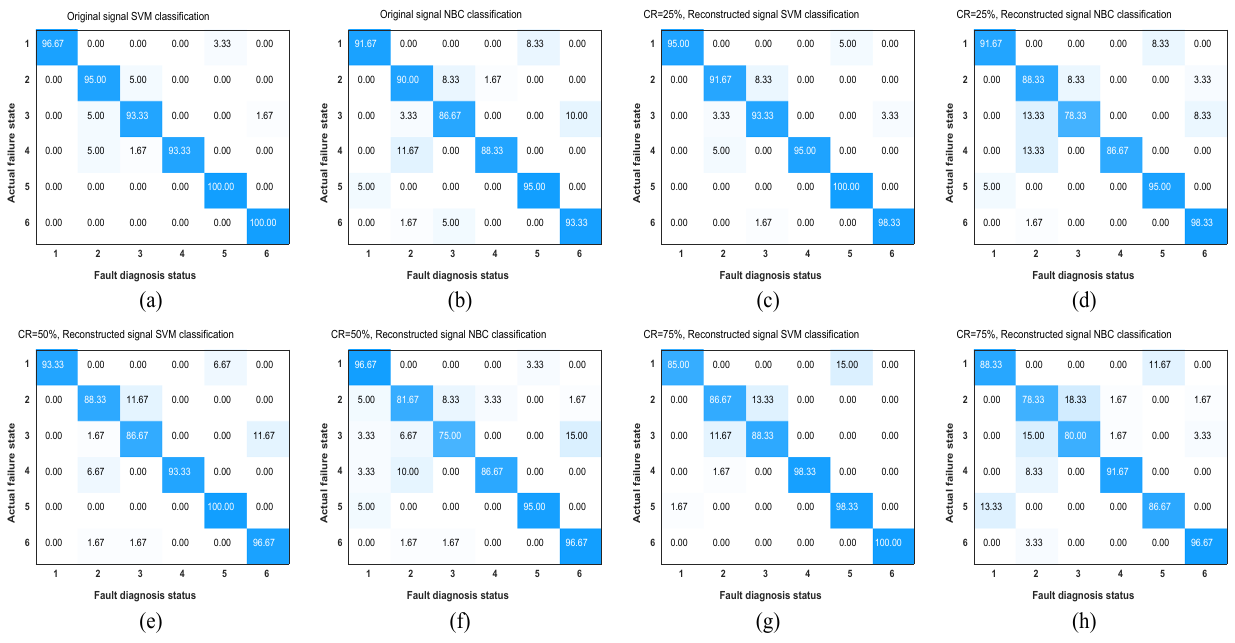
Figure 11. Comparative analysis of fault classification under different compression ratios: ( a ) Original signal SVM classification; ( b ) original signal NBC classification; ( c ) CR = 0.25, SVM classification; ( d ) CR = 0.25, NBC classification; ( e ) CR = 0.5, SVM classification; ( f ) CR = 0.5, NBC classification; ( g ) CR = 0.75, SVM classification; and ( h ) CR = 0.75, NBC classification. Table 2. Comparative analysis of fault classification under different compression ratios.